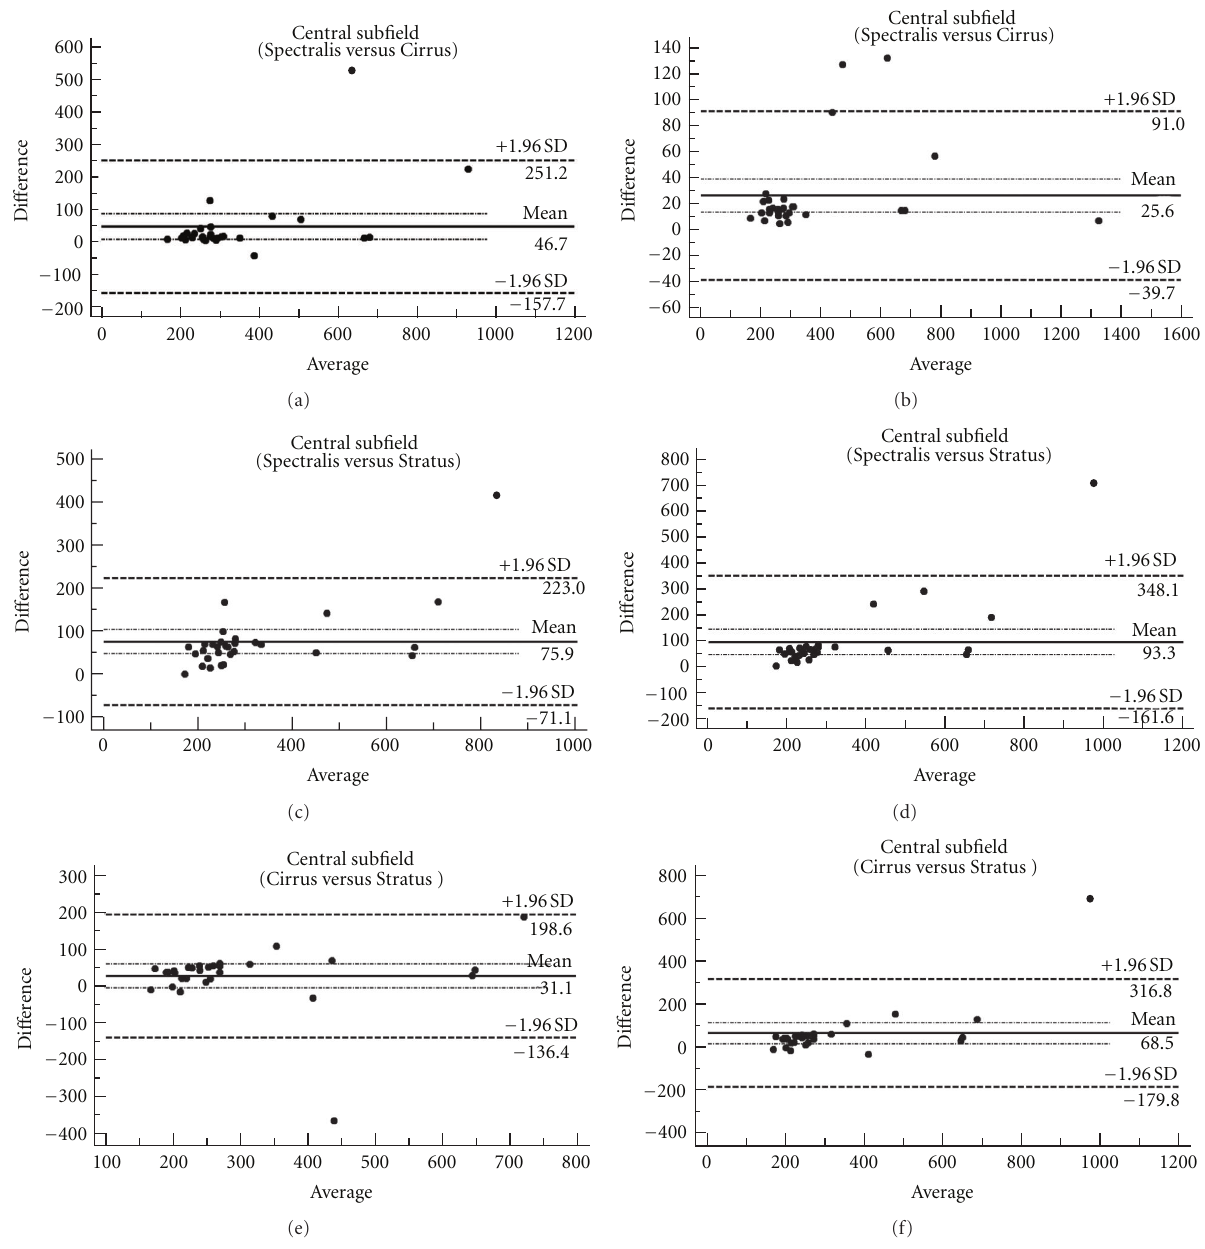
Figure 2: Bland-Altman plots of central subfield macular thickness between each device for the values before manual correction of algorithms (a, c, and e) and after manual correction (b, d, and f) in eyes with vein occlusion. Solid lines: average mean di ff erence; dotted lines: 95% confidence limits of